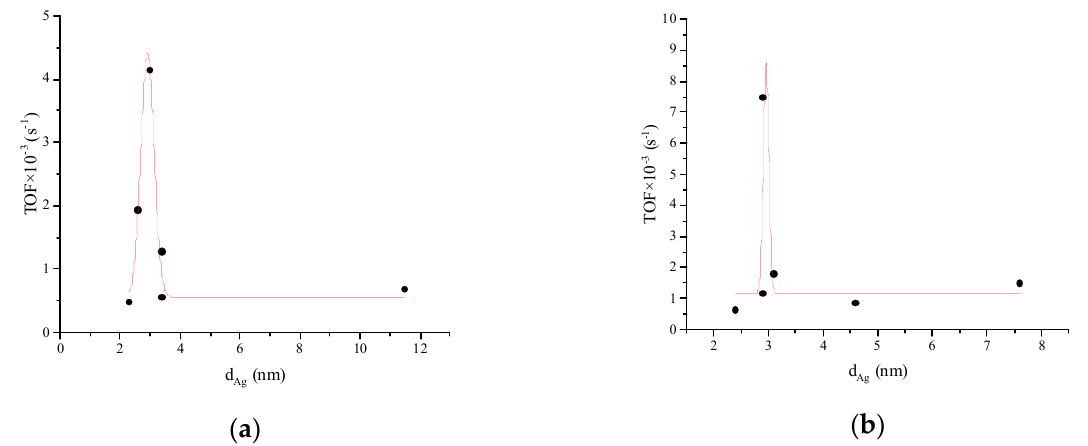
Figure 4. TOF dependence as a function of the mean Ag particle size: ( a ) for materials prepared by deposition–precipitation with NaOH method; ( b ) for materials prepared by incipient wetness impregnation method.